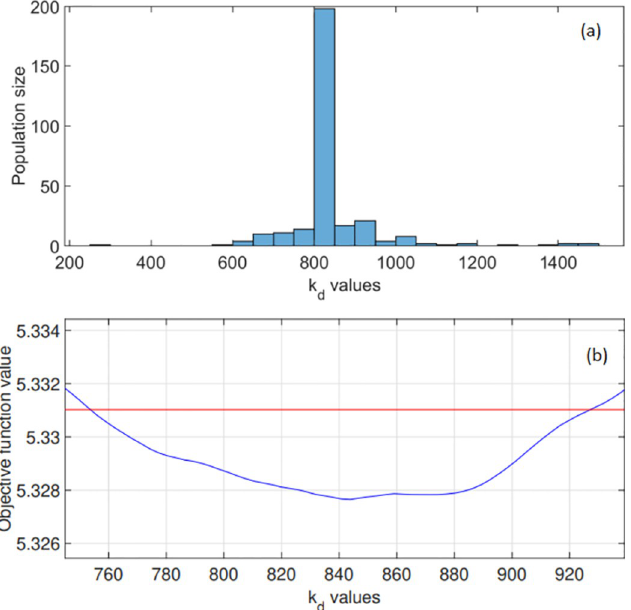
Fig 3. Global optimisation results for the stomatal parameter k d in expression 16. (a) The range of potential k d values considered is shown along with the optimised k d distribution. The genetic algorithm converged to a parameter on the interval [800, 850], with the optimised k d = 830.3 s. (b) Objective function values: computed profile likelihood for a range of k d values. The 95% confidence interval is shown in red as [735.6, 927.5] s.